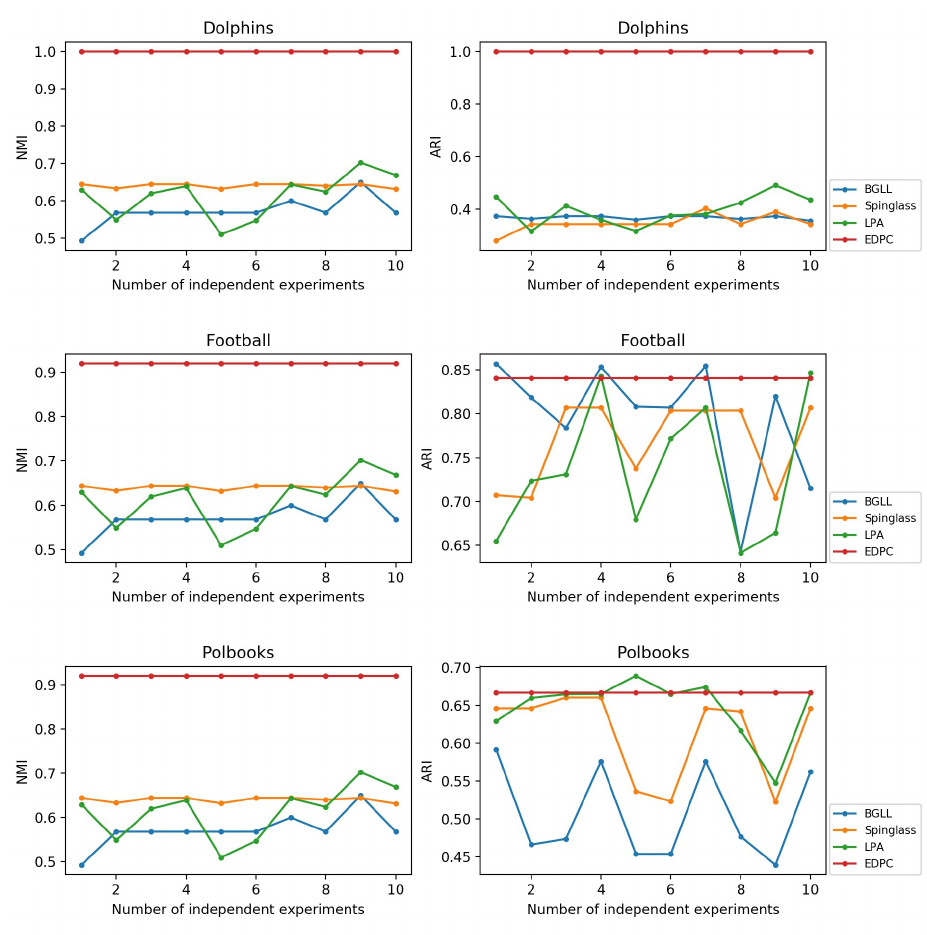
Figure 5. Comparison of NMI and